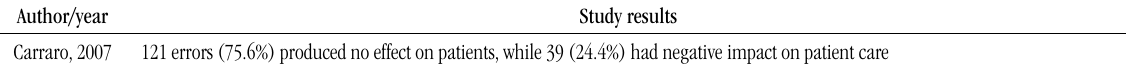
tABLE 4 – Adverse events, clinical impacts and preventability described in the studies, by author and publication year (cont.) Author/year Study